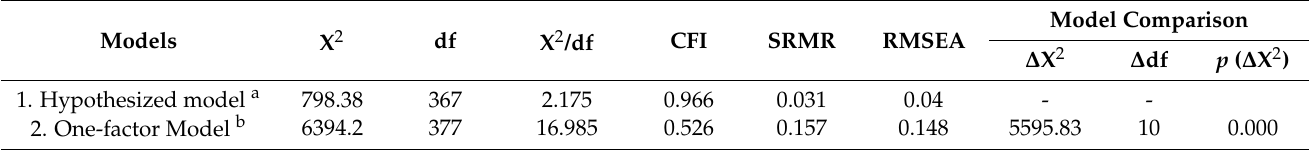
Table 4. Comparison of the goodness-of-fit values of the research model with single factor